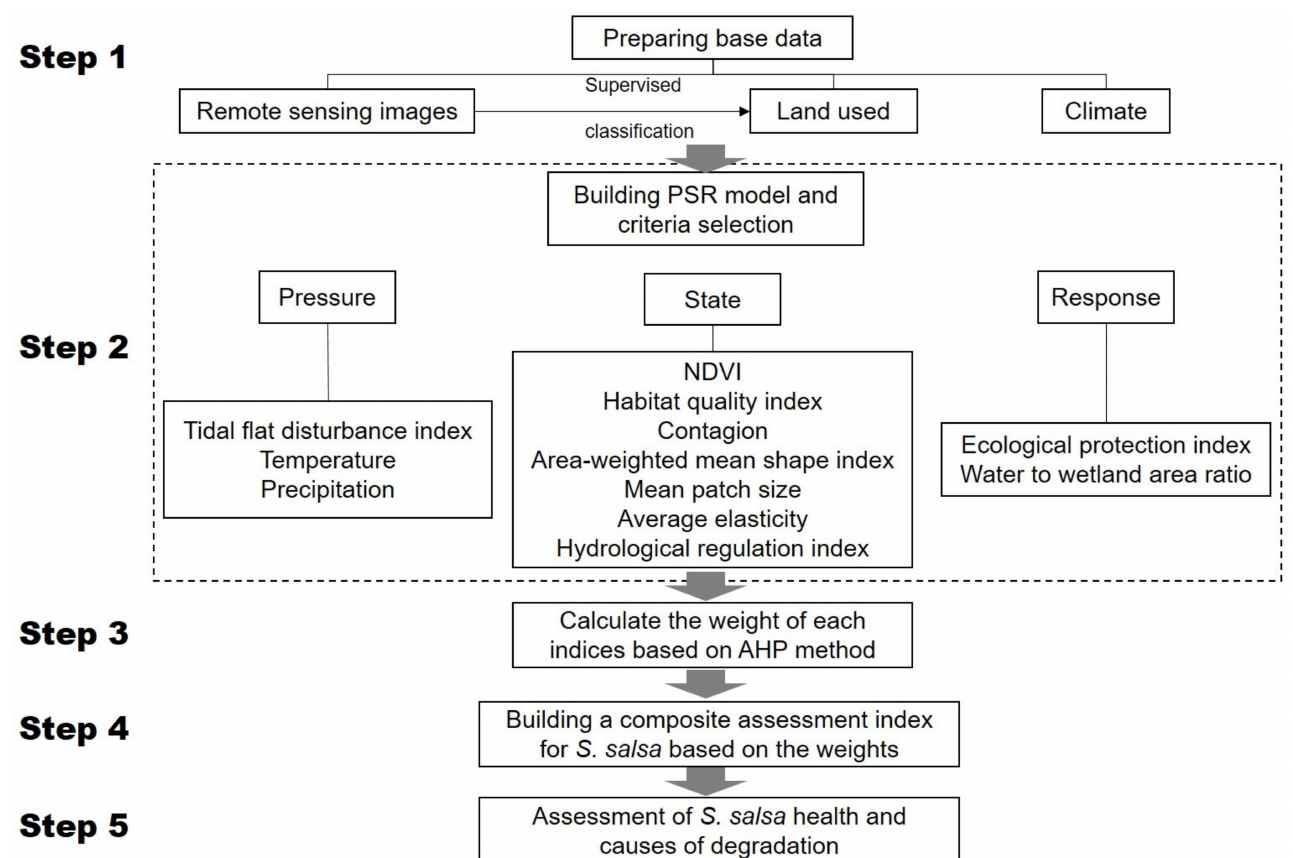
Figure 2. Technical process framework for the construction of the PSR